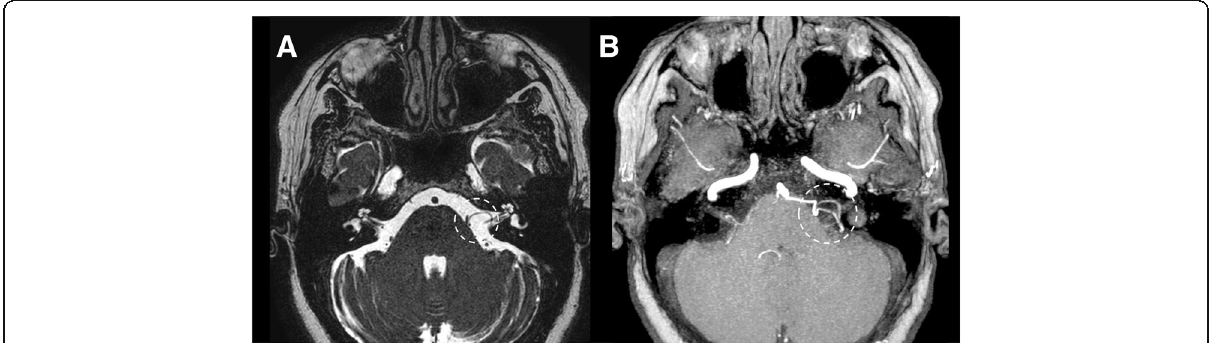
Fig. 30 Neurovascular compression of facial nerve. Patient with left facial nerve palsy. MRI axial steady-state free procession ( a ) and T1-weighted post-gadolinium, MIP reconstruction ( b ) images show a neurovascular compression of the left facial nerve (dotted circles)